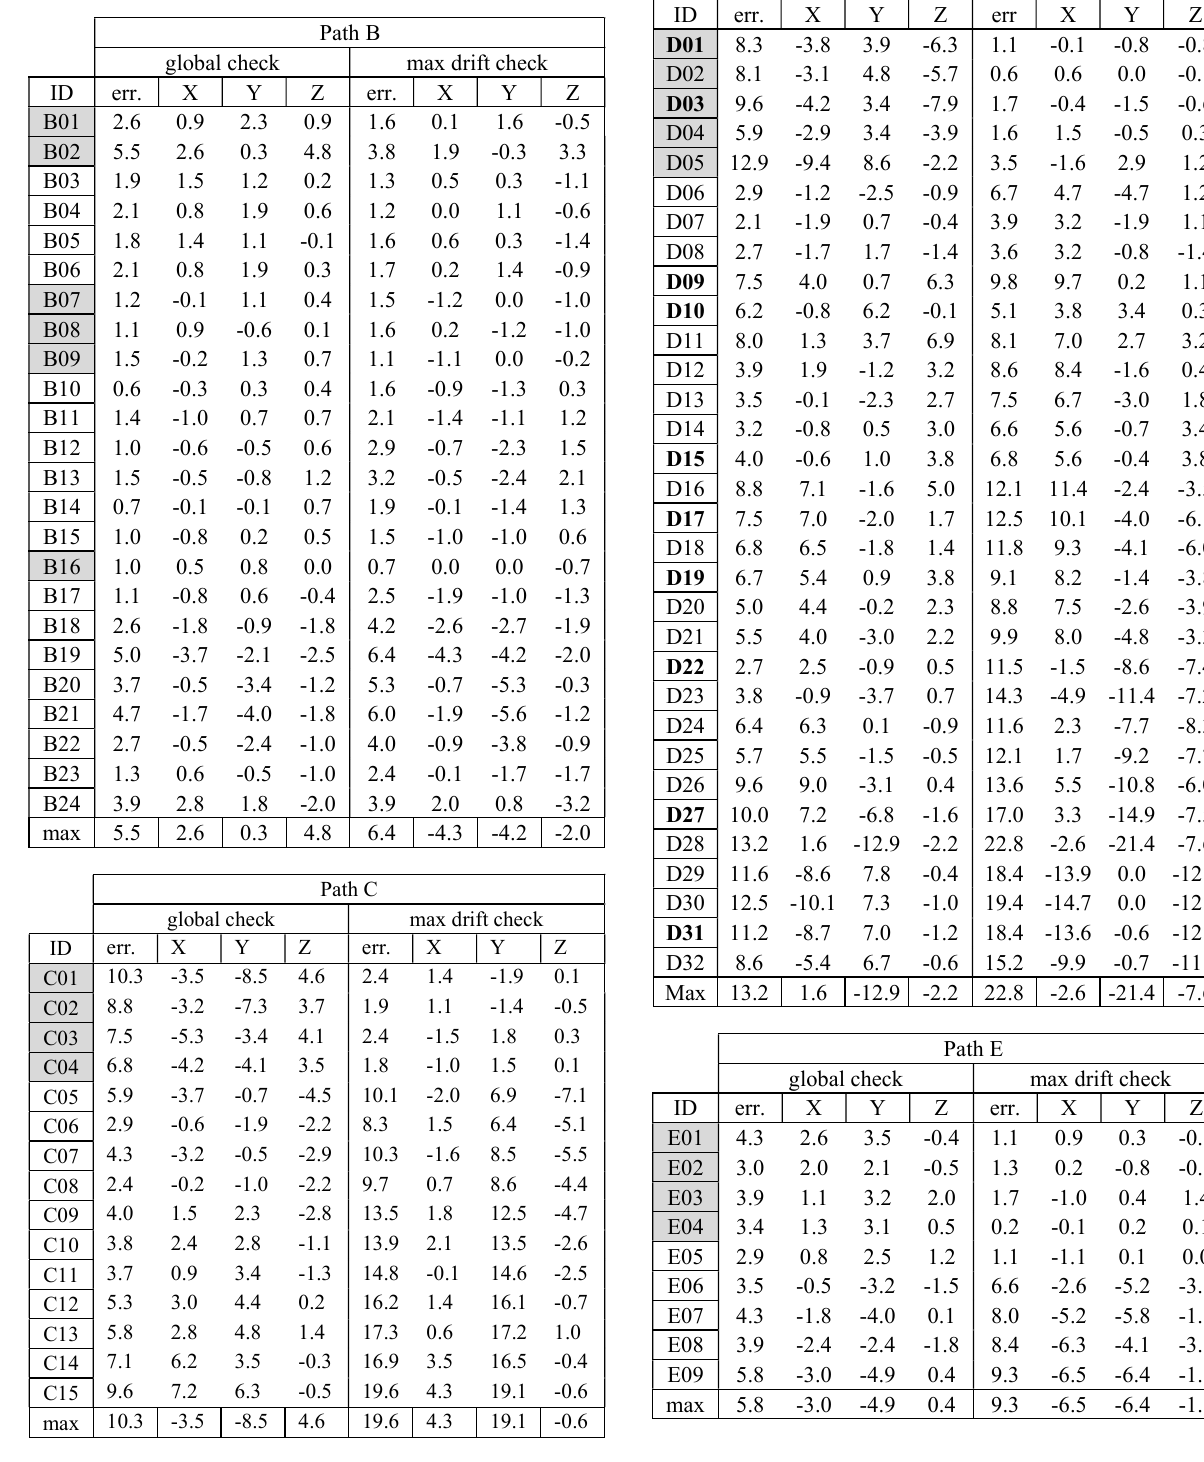
Table 3. Error check of Path B, C, D and E. For “global check” all points are used as CPs, while for “max drift check” points highlighted in grey are used as GCPs in a similarity transformation. Only for Path D an additional check was performed by using GCPs in the bundle adjustment (Bold IDs), the results are described in the conclusions. All errors are expressed in